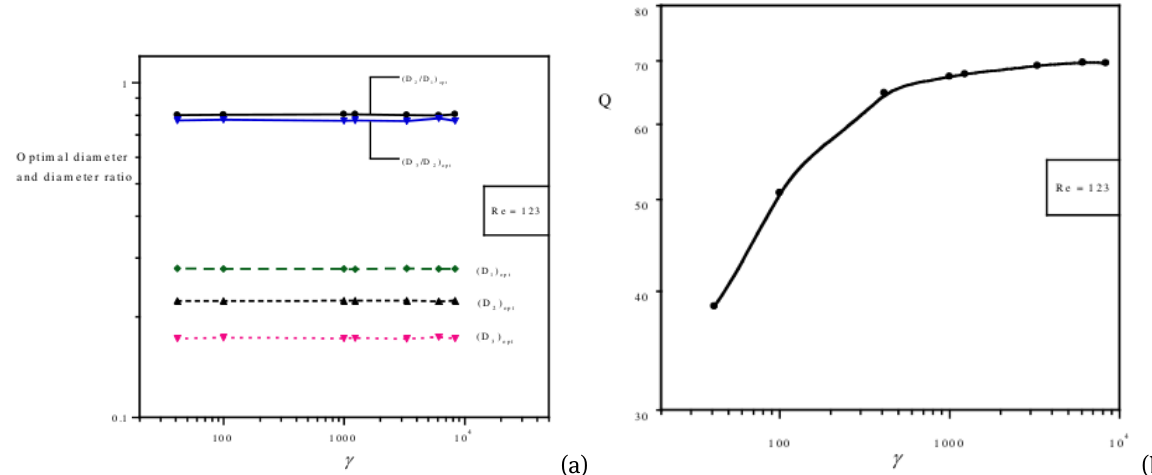
Figure 5: (a) The effect of the thermal conductivity ratio on the optimized geometric Configurations for a triple row finned heat sink at a Reynolds number of 123. (b) The effect of the conductivity ratio on the maximized heat transfer rate for a triple row micro heat sink for a Reynolds number of